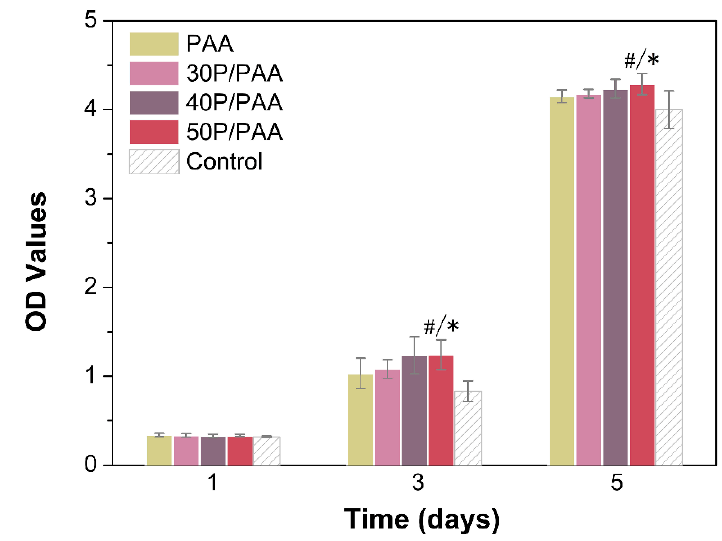
Figure 7. Cell proliferation on PAA and the composites for 1, 3 and 5 days based on a cell counting kit-8 assay. * Significant difference compared with control group ( p < 0.05); # significant difference compared with PAA group ( p < 0.05).